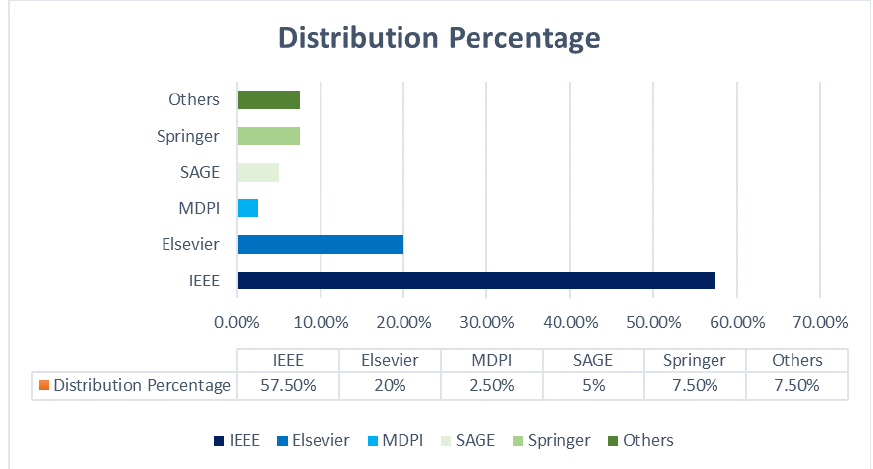
Figure 5. Distribution based on publishing venue.